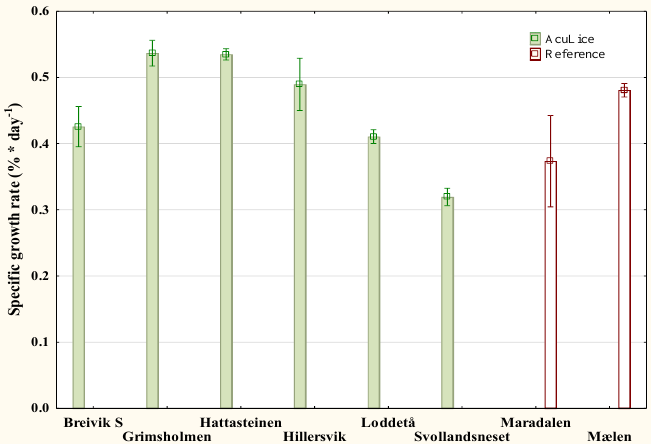
Figure 4. Mean specific growth rate (SGR (% day -1 )) calculated for Atlantic salmon at each experimental facility in field trial 2 in the period from mid-summer 2019 to late-spring 2020. The AcuLice-treated facilities are marked in green, and the reference group is marked in red. Data from each production facility is presented as mean ± SEM (N = 30). Note that data from the reference facility Seglberget is missing due to missing weight measurements.